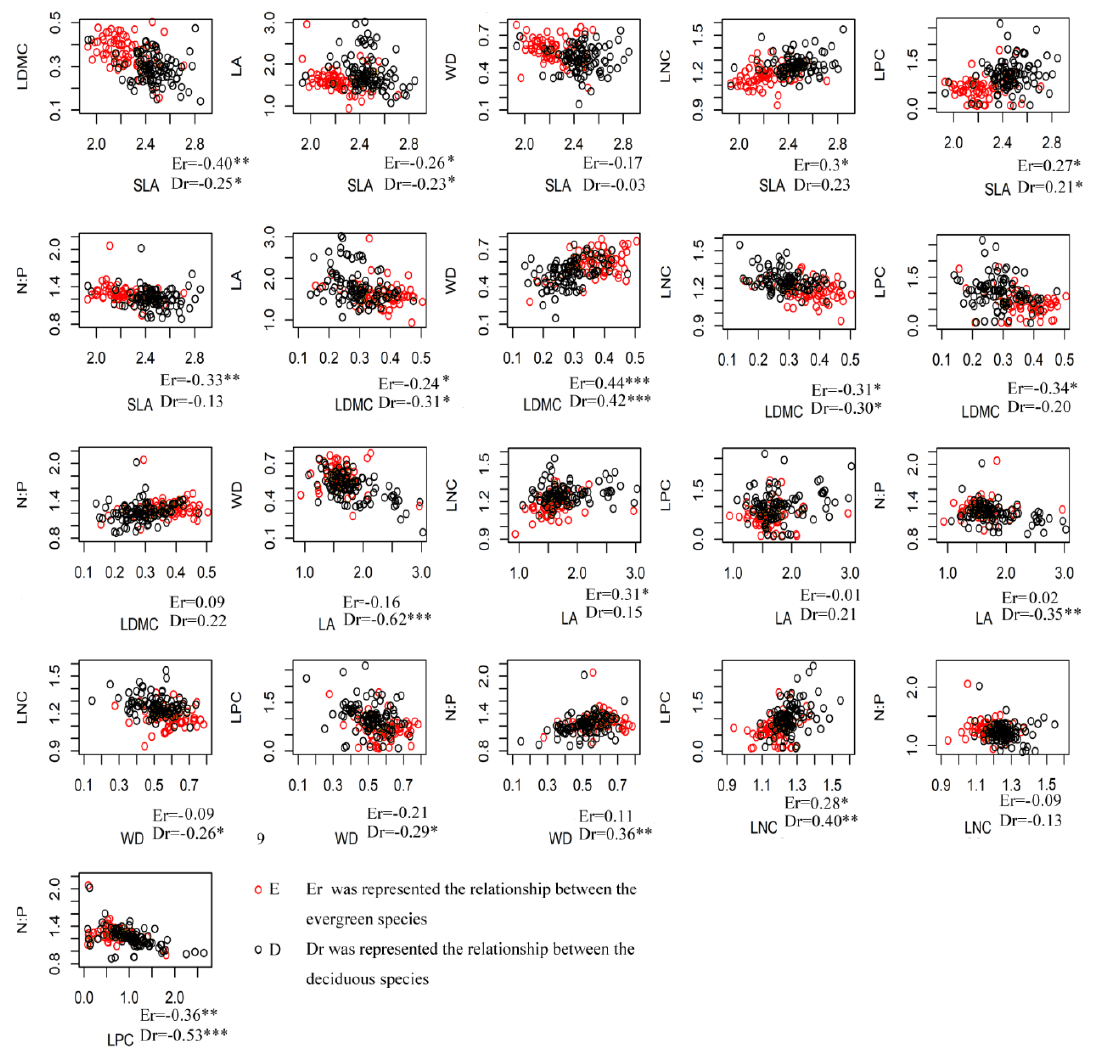
Figure 3. Scatterplots of species’ mean trait values for all pairwise combinations between evergreen and deciduous species for the seven functional traits in a subtropical evergreen deciduous broadleaved mixed forest in Central China. (* p < 0.05; ** p < 0.01; *** p < 0.001). Note: The red circles represent evergreen species, and the green circles represent deciduous species.